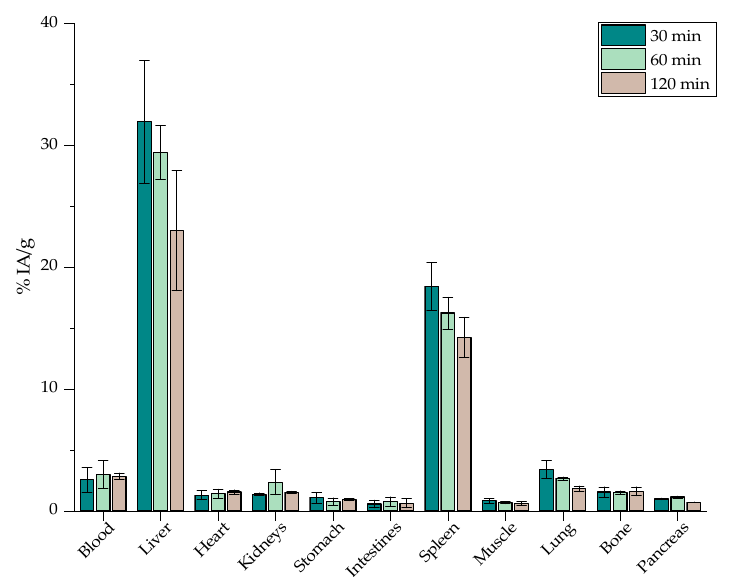
Figure 13. Biodistribution of [ 68 Ga]Ga-MAPEG in normal mice expressed as % IA/g ( n = 3). It is well established that the fate of nanoparticles following systemic administration is highly correlated to parameters such as their size and their surface coating [66]. In general, nanoparticles of ≈ 100 nm after intravenous injection are rapidly covered by opsonins and thus recognized by cells of the MPS. Similar nanosystems reported by Pa- padopoulou et al . , with a highly negative surface charge ( − 36 mV versus − 40 mV in the case of [ 68 Ga]Ga-MA), seem to have more interactions with macrophages and highly ac- cumulate in organs such as the liver and spleen but also in lungs, especially at 30 min p.i. [45]. In most cases reported, surface functionalization with a biocompatible coating dis- plays similar in vivo biodistribution as in the case of [ 68 Ga]Ga-MAPEG. Gallium radio- labeled iron oxide nanoparticles described by Lahooti et al . as well as by Karageorgou et al . , coated with PEG or 2,3-dicarboxypropane-1,1-diphosphonic acid (DPD), respectively, were mainly detected in the liver and spleen and remained in these organs up to 120 min p.i. [28,67]. 3.9. Ex Vivo Biodistribution Studies of [ 177 Lu]Lu-MAPEG in Normal Mice After evaluating the biodistribution results of the [ 68 Ga]Ga-MIONs and according to the 3Rs principle in animal experimentation (Replace, Reduce, Refine; Directive 2010/63/EU), only the biodistribution pattern of [ 177 Lu]Lu-MAPEG was investigated due to the more favorable in vitro and ex vivo profile of the 68 Ga-MAPEG counterpart. Since 177 Lu is a much longer-lived isotope to be used in therapeutic applications, biodistribu- tion experiments were conducted after 1 d, 2 d, and 7 days post-injection. The results shown in Figure 14 denote a similar behavior of [ 177 Lu]Lu-MAPEG compared to [ 68 Ga]Ga-MAPEG. In general, nanoparticle uptake to the liver seems to fol- low a slight upward trend at 1- and 2-days post-administration (22.78 ± 4.34% and 27.22 ± 3.72%, respectively) and demonstrates a stable spleen accumulation (12.89 ± 1.32% at 2 d compared to 12.67 ± 0.24% at 7 d p.i.). Nevertheless, one week after injecting the mice with [ 177 Lu]Lu-MAPEG, liver uptake decreased (20.13 ± 6.29%). Liver and spleen uptake was pronounced up to 7 days p.i., while retention at the rest of the organs was below 5%. We would like to note that lung accumulation of the radiotracer follows the decreasing trend observed up to 2 h p.i in the case of [ 68 Ga]Ga-MAPEG.